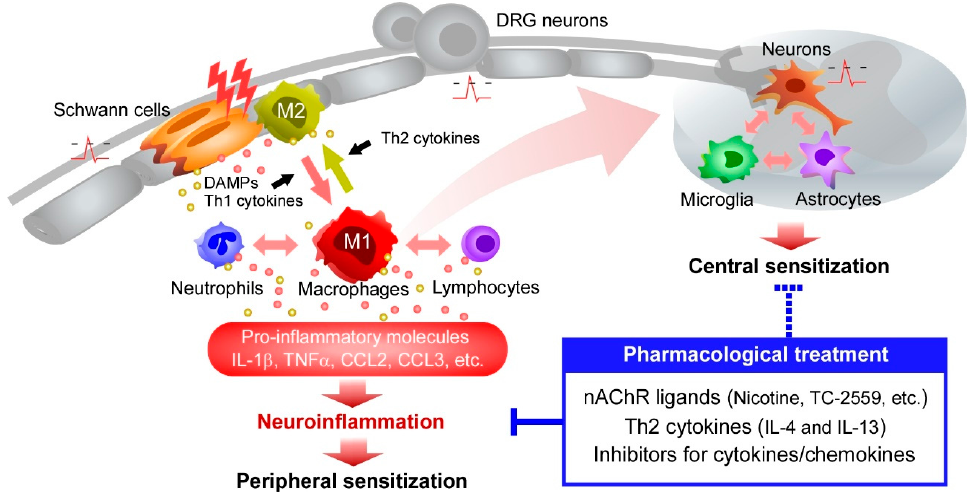
Figure 2. Generation of neuropathic pain by macrophage-driven inflammation in the peripheral nervous system. After nerve injury, activated resident cells (Schwann cells and macrophages) produce soluble factors such as damage-associated molecular patterns (DAMPs) that activate nearby cells and recruit circulating leukocytes (macrophages, neutrophils, and lymphocytes) to the site of injury. Macrophages are the most abundant infiltrating leukocyte population and are thought to play a central role in regulating peripheral neuroinflammation. Tissue-resident and infiltrating leukocytes communicate through the release of pro-inflammatory mediators such as cytokines and chemokines, which convey nociceptive information to dorsal root ganglia (DRG) neurons. Persistent ectopic activity of DRG neurons induces central sensitization characterized by the enhanced activity of pain-processing neurons and the activation of microglia and astrocytes. Pharmacological targeting of macrophages or macrophage-derived pro-inflammatory molecules by nicotinic acetylcholine receptor (nAChR) ligands, Th2 cytokines, and inhibitors of cytokines and chemokines can suppress macrophage-driven neuroinflammation after nerve injury. The reduction in neuroinflammation improves both peripheral and central sensitization and alleviates intractable neuropathic pain.